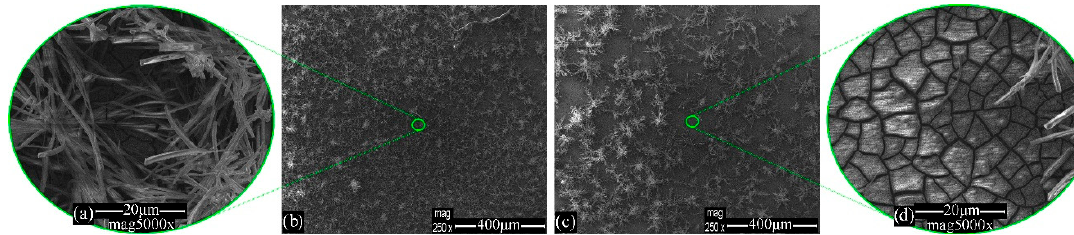
Figure 6. SEM images of mild steel immersed in WSS for 96 h in the presence of Na 2 HPO 4 and 2-mecraptobenzothiazole (MBT).